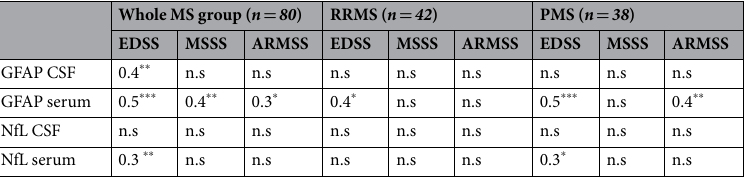
Table 2. Correlation matrices in different subgroups. RRMS: all relapsing-remitting MS patients (RRMS- and RRMS + ); PMS: all patients with progressive MS (SPMS and PPMS); values are Spearman r, * p-value < 0.05; ** p-value < 0.01; *** p-value < 0.001. EDSS: expanded disability score scale, MSSS: multiple sclerosis severity score, ARMSS: age-related multiple sclerosis severity score.